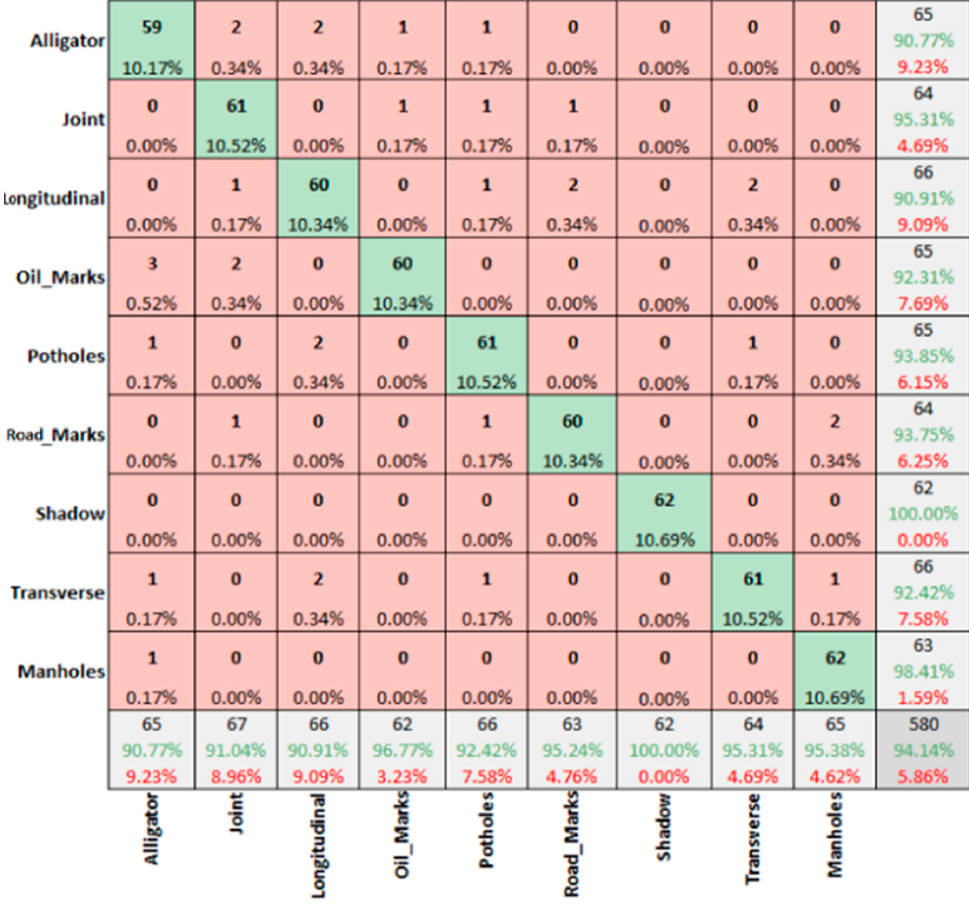
Figure 8. Winter sunny condition—DC